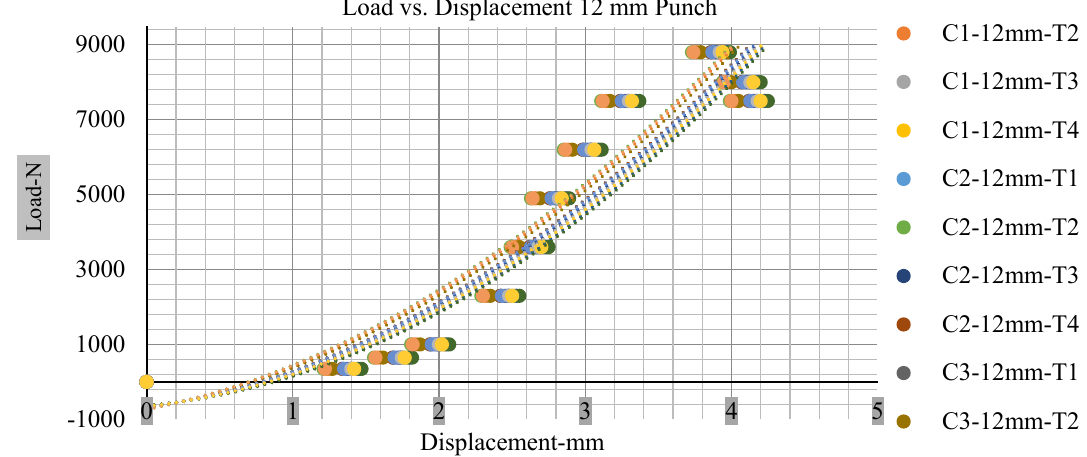
Figure 14. Load vs. displacement 12 mm low to peak loads.